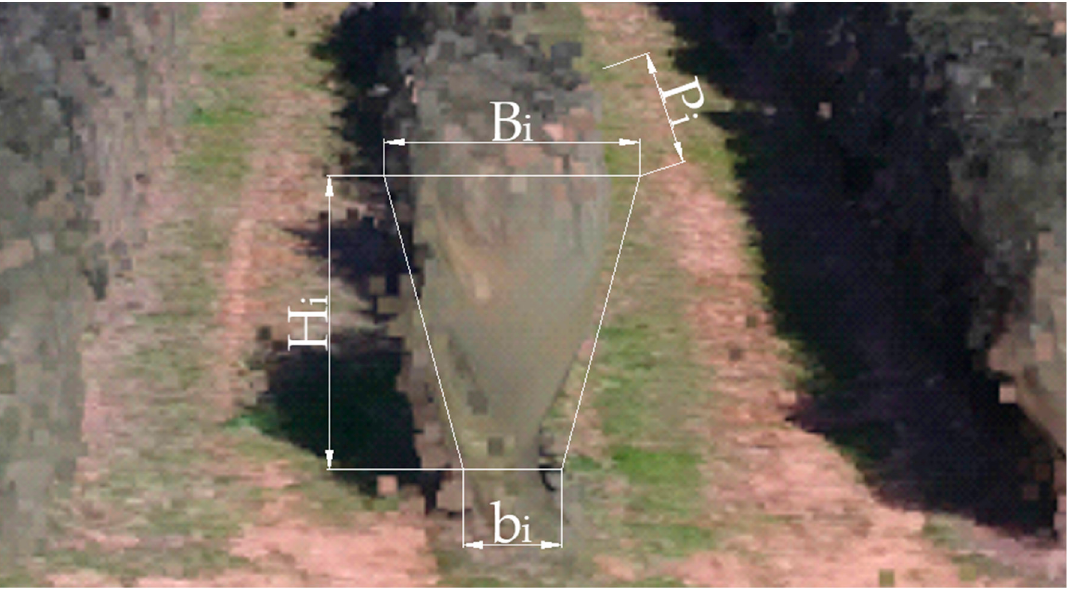
Figure 6. Tree crown geometry for the TRV 2 estimation method.